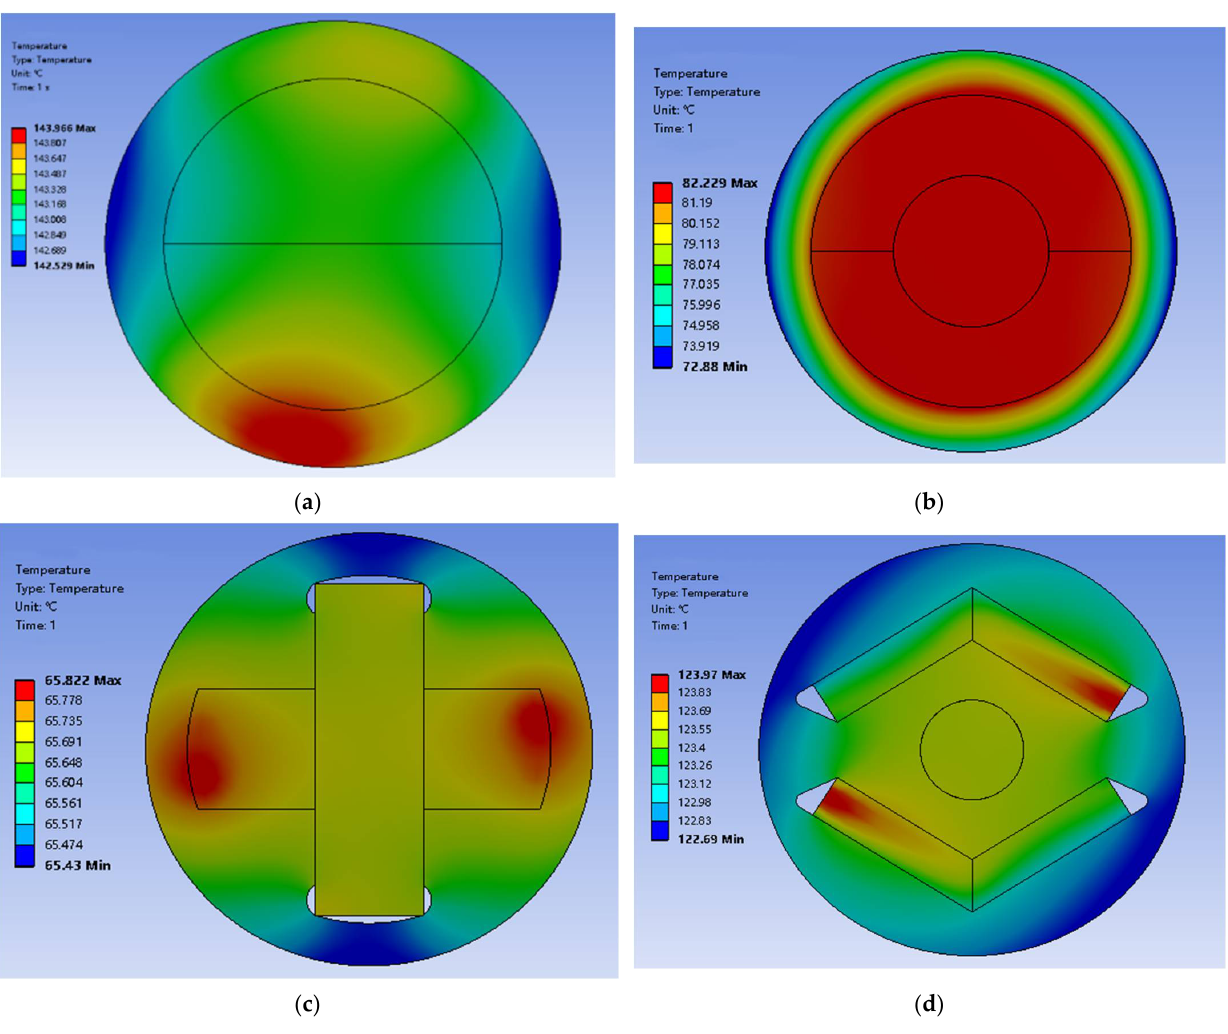
Figure 12. Temperature distribution on rotor of HSPMSMs at rate load. ( a ) M1; ( b ) M2; ( c ) M3; ( d ) M4.